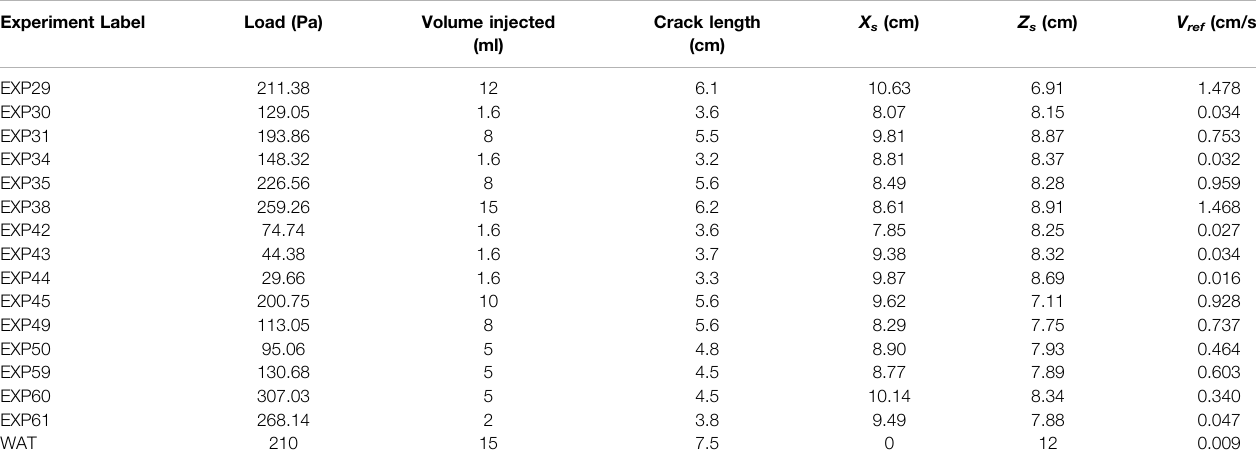
TABLE 1 | Velocity of reference V ref for all experiments